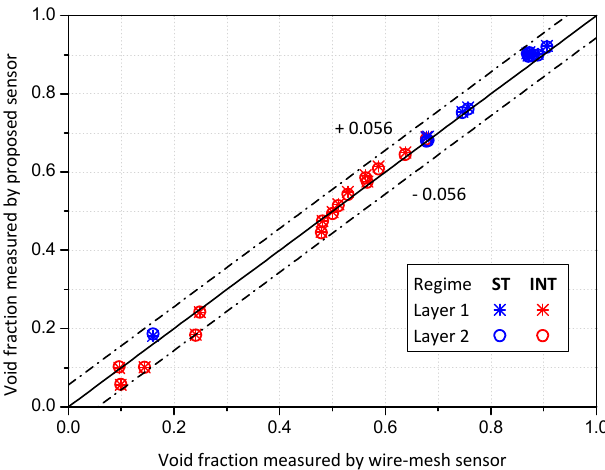
Figure 11. Comparison between the time-averaged void fractions measured by the proposed sensor and the wire-mesh sensor (note: ST and INT stand for the stratified and intermittent flow regimes, respectively).